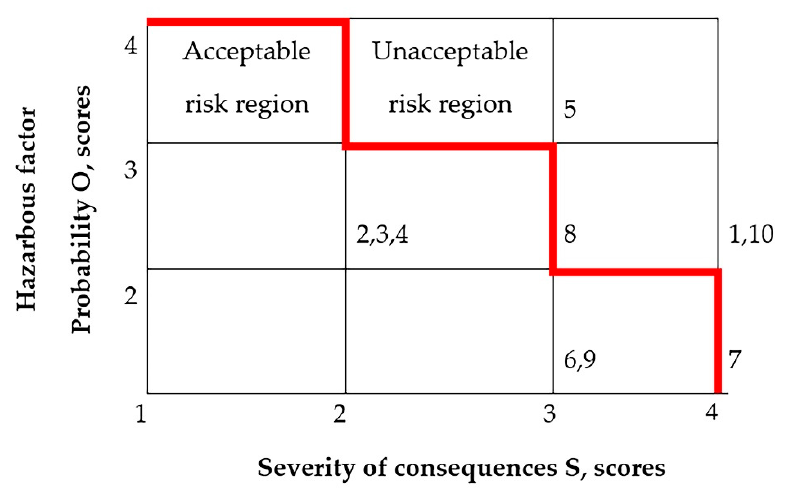
Figure 4. Diagram of analyzing the risks of the process of “Developing a Model of Rolling Mill Loading with Orders with Overlapping Stock”.